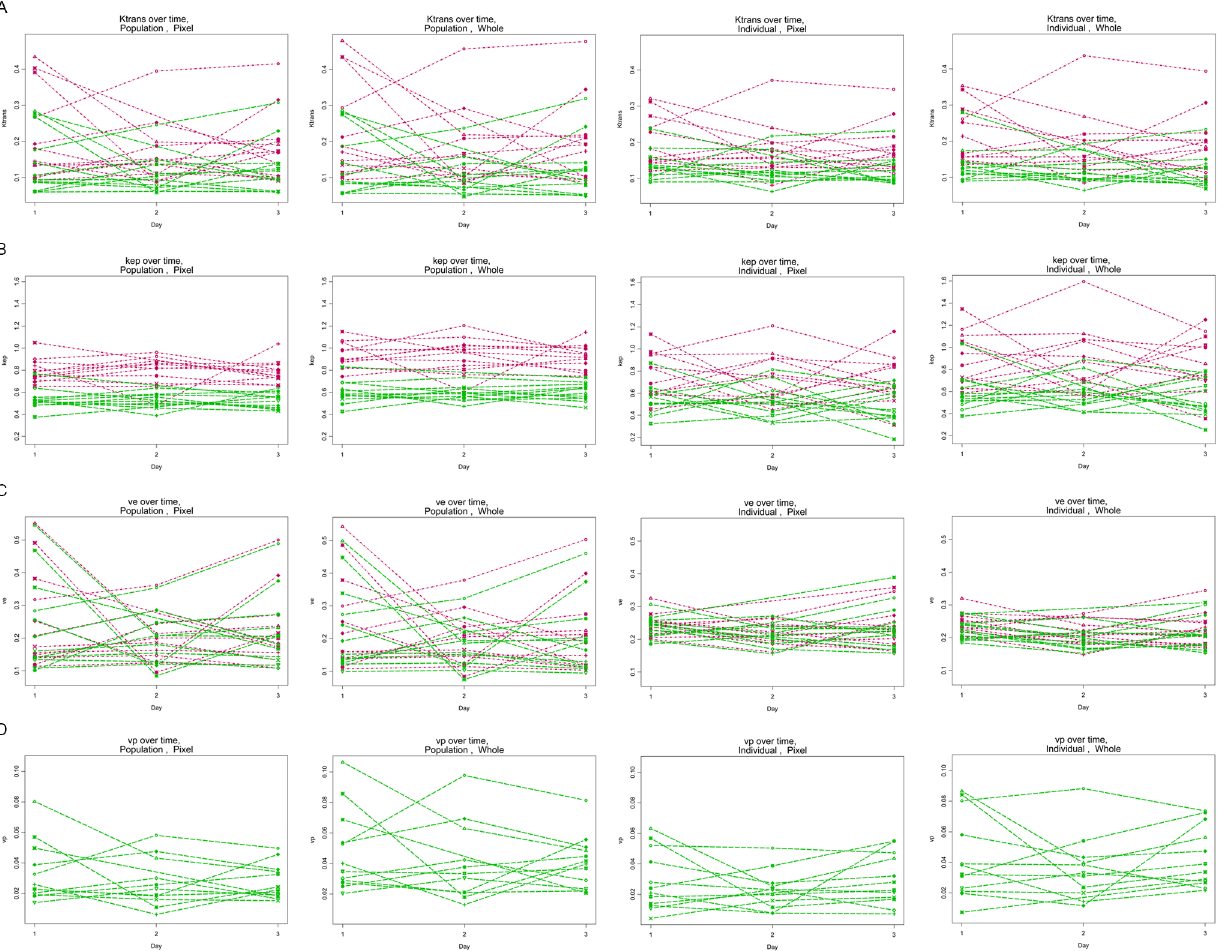
Fig 3. Scatter plots of 3 day time points, of horizontal row a) K trans , b) k ep , c) v e , d) v p , by 2- (red lines) vs. 3-parameter (green lines) models; with separate plots for pixel-by-pixel vs. whole tumor analyses, and by individual- vs. population-based VIFs. Y-axes for K trans and k ep in min -1 : v e and v p